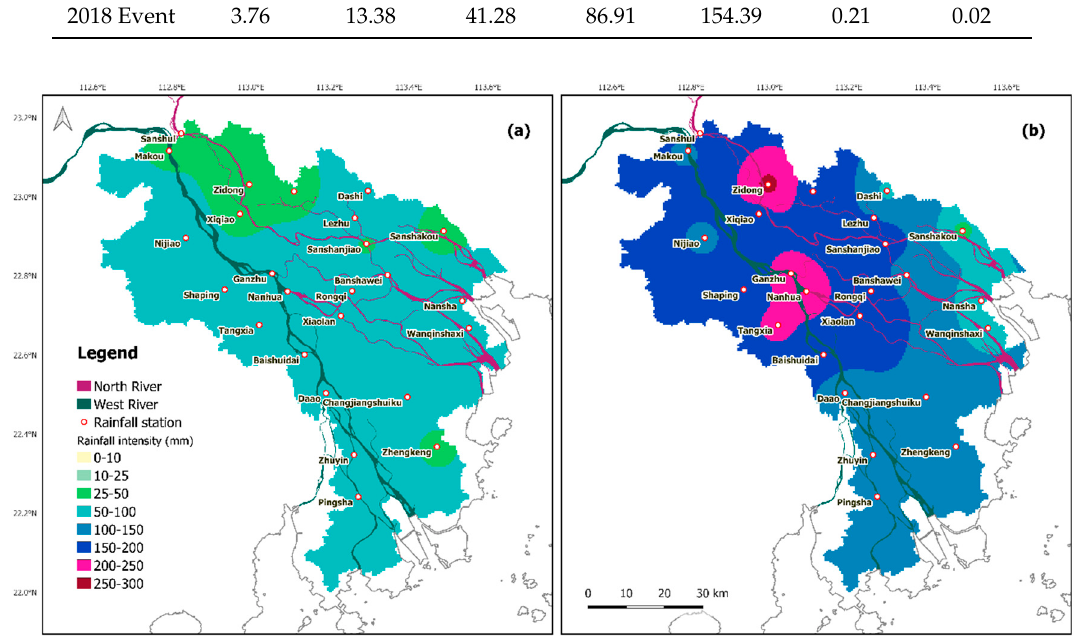
Figure 4. The maximum daily isohyet map based on the 25 rainfall gage station data occurred during the two historical events: ( a ) 3 July 2017, and ( b ) 8 June 2018. The isohyets were calculated based on the Inverse Distance Weight method.